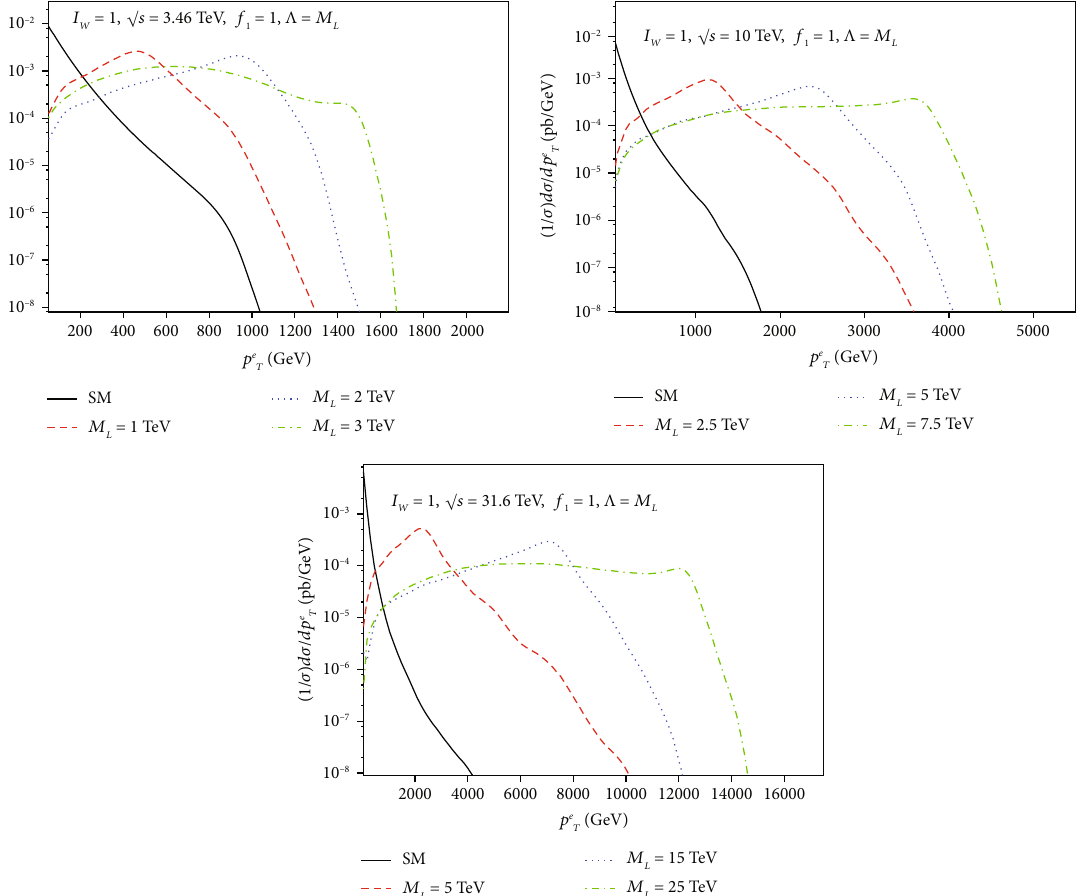
= 1 multiplet for f W